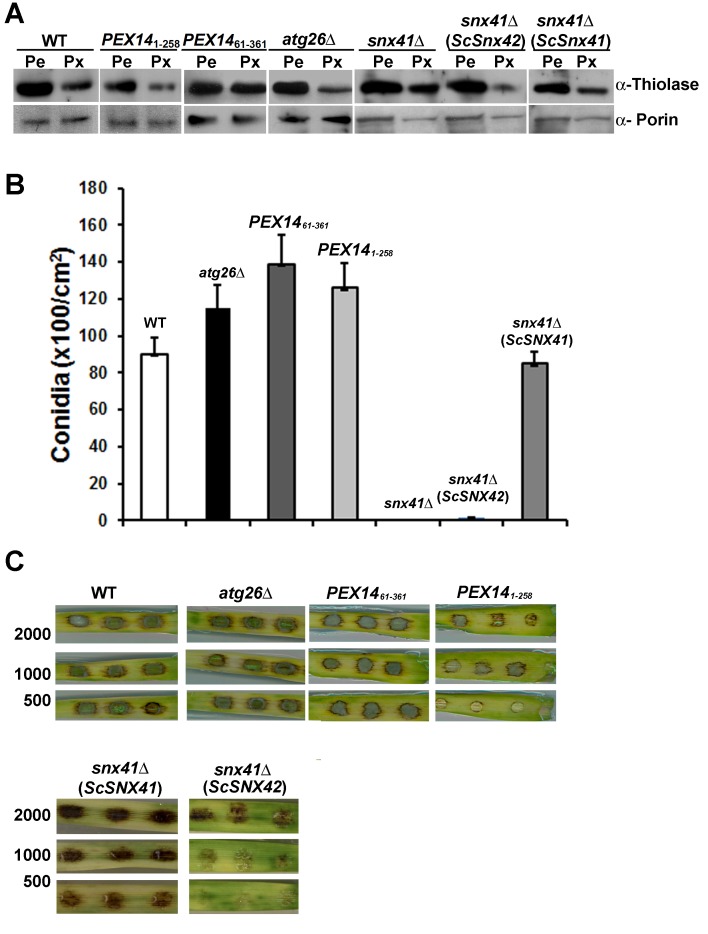
Characterization of conidiation and pathogenicity in pexophagy-deficient strains.(A) Detection of pexophagy defects by biochemical assay. WT, atg26Δ, PEX14
1-258, PEX14
61-361, snx41Δ and the two complemented strains were grown in peroxisome biogenesis (Pe) or pexophagy induction (Px) conditions. The total lysates from aforementioned strains were subjected to immunoblotting with anti-thiolase (Thi) antibody. The immunoblot was reprobed with anti-Porin antisera as loading control. Percentage denotes reduction of Thiolase in Px condition compared to the Pe condition, as an indicator of pexophagy efficiency. Percentage reduction was calculated using ImageJ [38] as follows: Percentage reduction of Thiolase level = (DensityPe-DensityPx)/DensityPe. (B) Bar chart depicting quantification of conidiation in the wild type (WT), atg26Δ, PEX14
61-361, PEX141
-258, snx41Δ, snx41Δ (ScSNX41) and snx41Δ (ScSNX42) strains grown on PA medium containing lactose as the sole carbon source. Note that values present averages (±S.E.) from three independent experiments (n = 30 colonies for each sample). Total conidia counts were performed 5 d post photo-induction. (C) Barley leaf explants were spot inoculated with conidia (2,000, 1000, and 500 per droplet) from wild type (WT), atg26Δ, PEX14
61-361, PEX141
-258, snx41Δ (ScSNX41) and snx41Δ (ScSNX42) strains. Disease symptoms were assessed 7 d post inoculation.